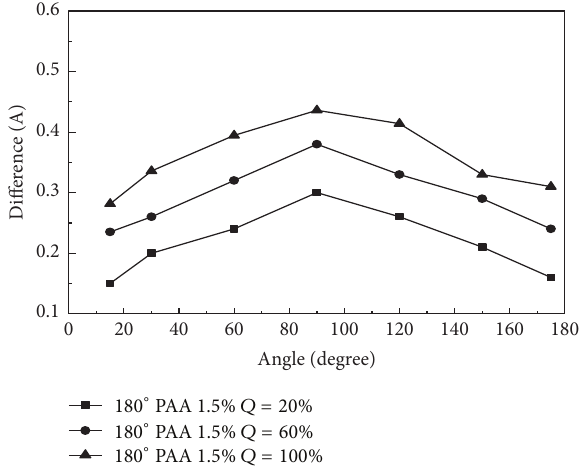
Figure 29: The PAS capillary number: difference diagram of various flows in 180 ∘ curved tube.